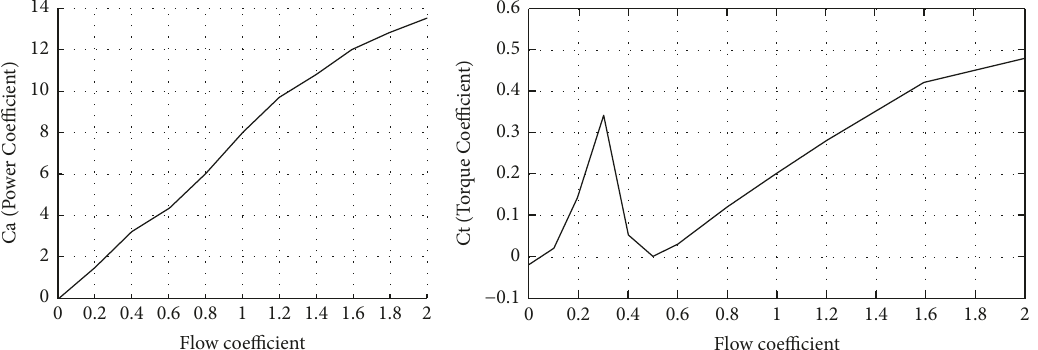
Figure 10: Relationship between flow coefficient-power coefficient and flow coefficient-torque coefficient.